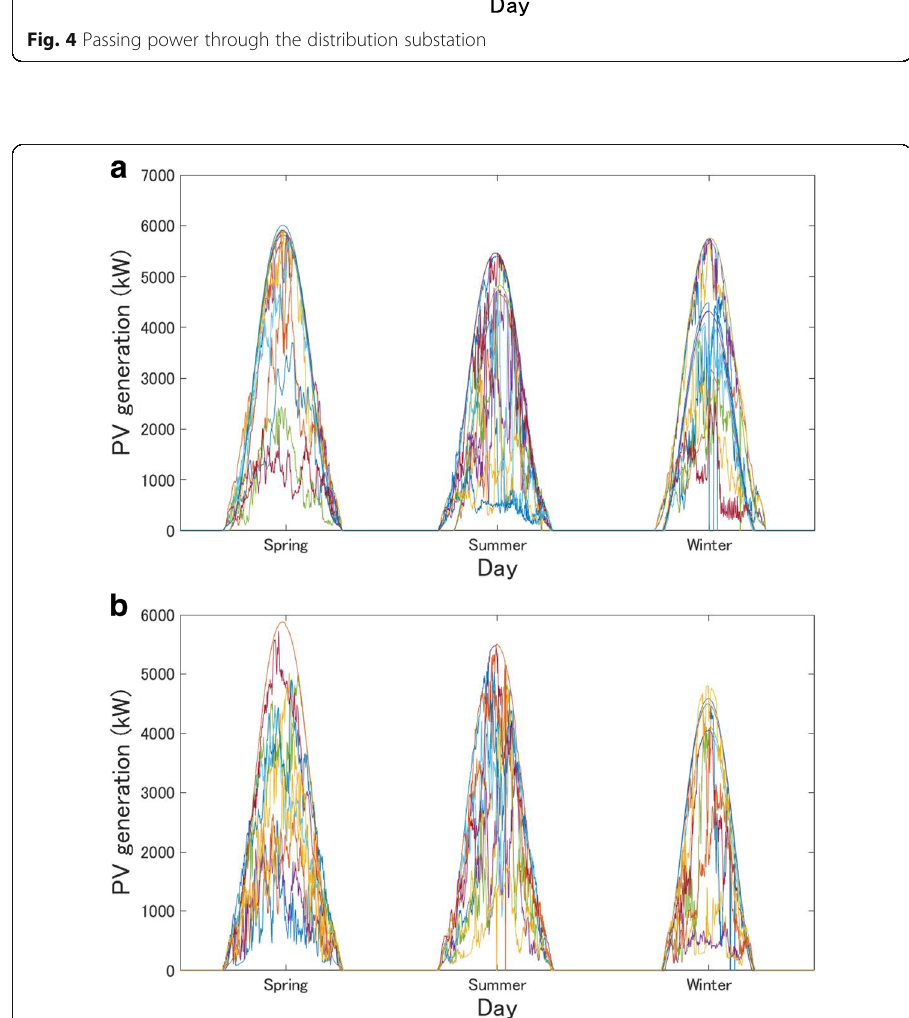
Fig. 5 A . PV generation waveform on the parameter determination data. B . PV generation waveform on the voltage evaluation data.